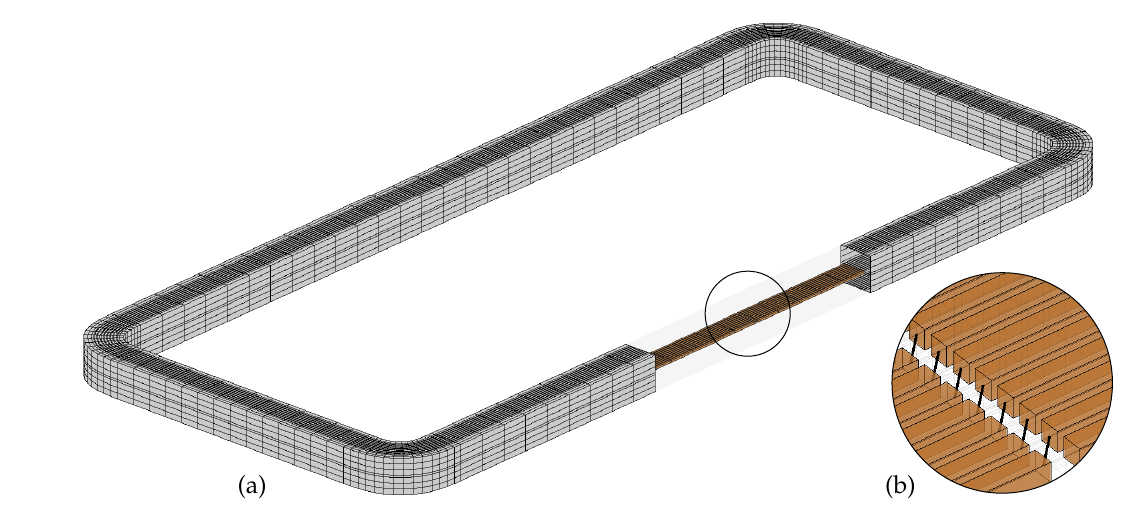
Figure 10. PEEC model of the embedded coil. ( a ) full model; ( b ) detail of the connection between the nine coil turns and the lumped